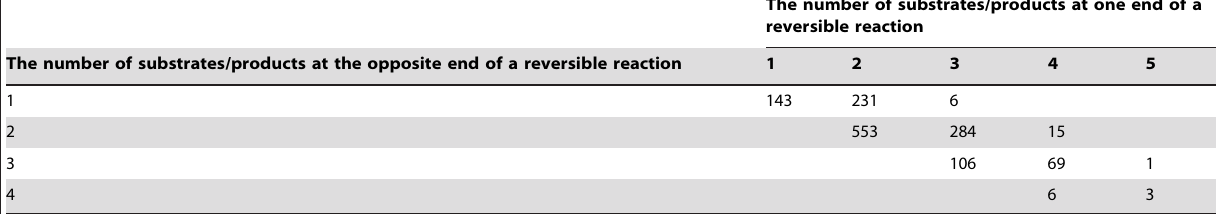
The number of substrates/products at one end of a reversible reaction